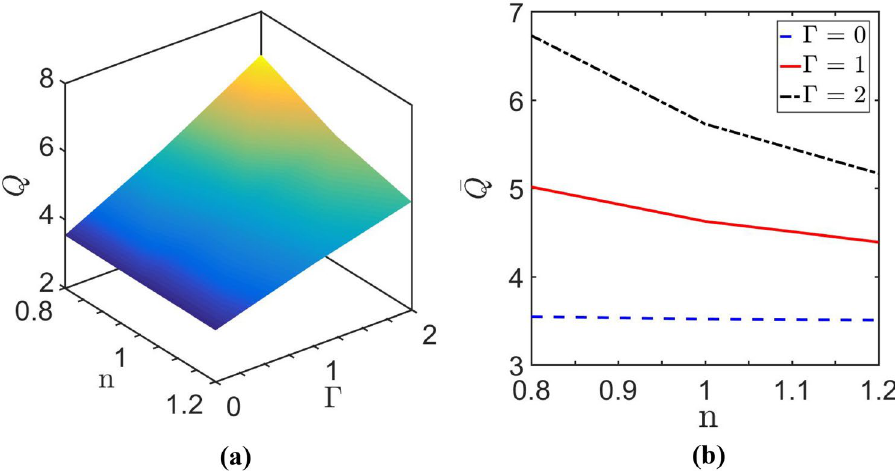
Q variation: ( a ) variation is shown in n − Ŵ plane; ( b ) variation is (cid:31) (cid:30)